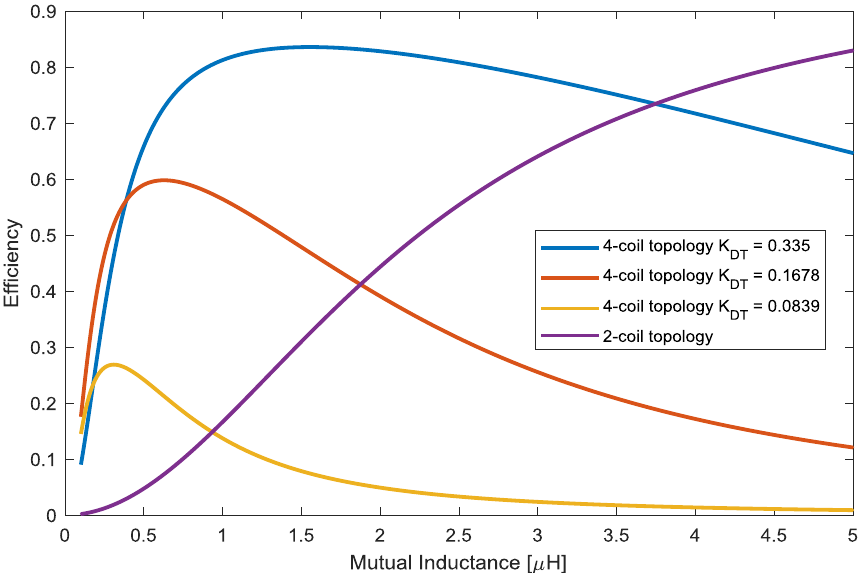
Figure 5. Comparison of the efficiency of a WPT system with two and four coils at a set operational frequency.